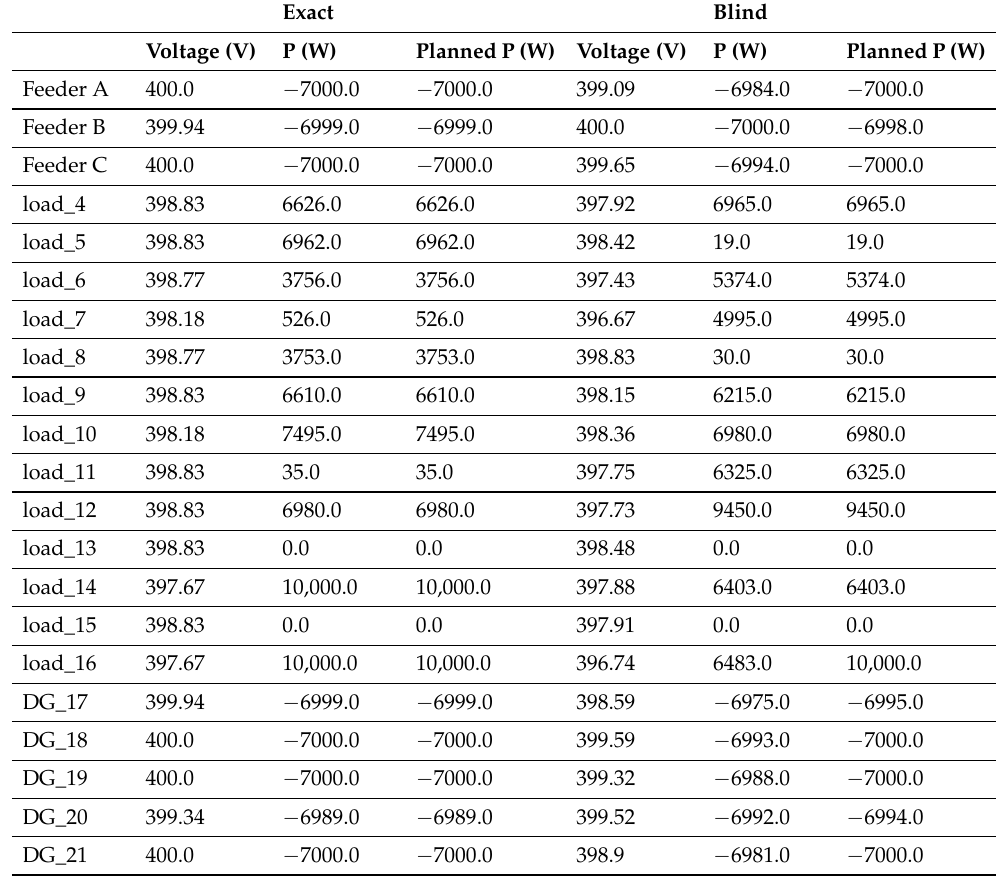
Table A1. One timestep of the simulation of the IEEE16 meshed grid with exernal grid connection. Comparison of the exact (fully-observable) and blind planners. Columns voltage (V) and p (W) correspond to the nodal voltage and power obtained by the executor; planned p (W) is the solution derived by the corresponding